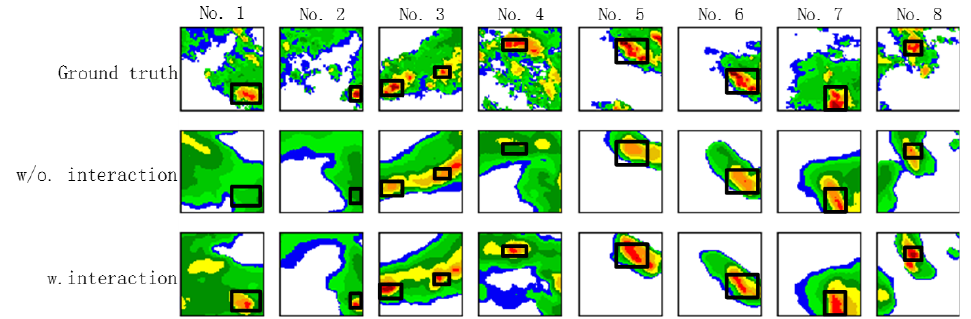
Figure 3. The first line is the eight ground truth examples and the rest are predictions after an hour without (second row) interaction and with (the last row). The color scheme is based on the color code in the right part (Best view in